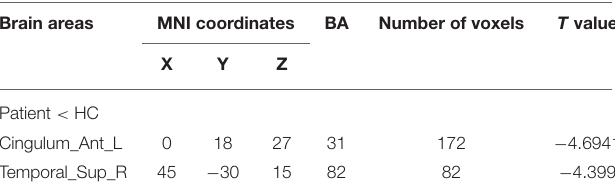
Frontiers in Neurology |